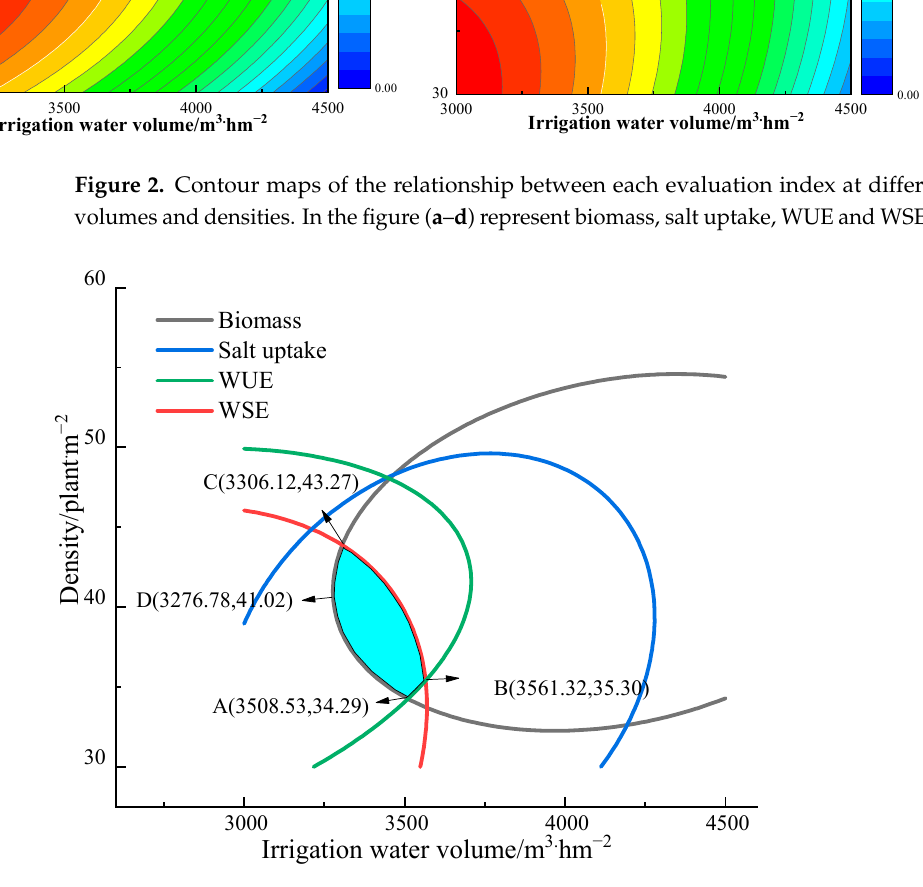
Figure 3. Concurrent evaluation of indices. The blue fi lled-in area meets the evaluation require- ments.